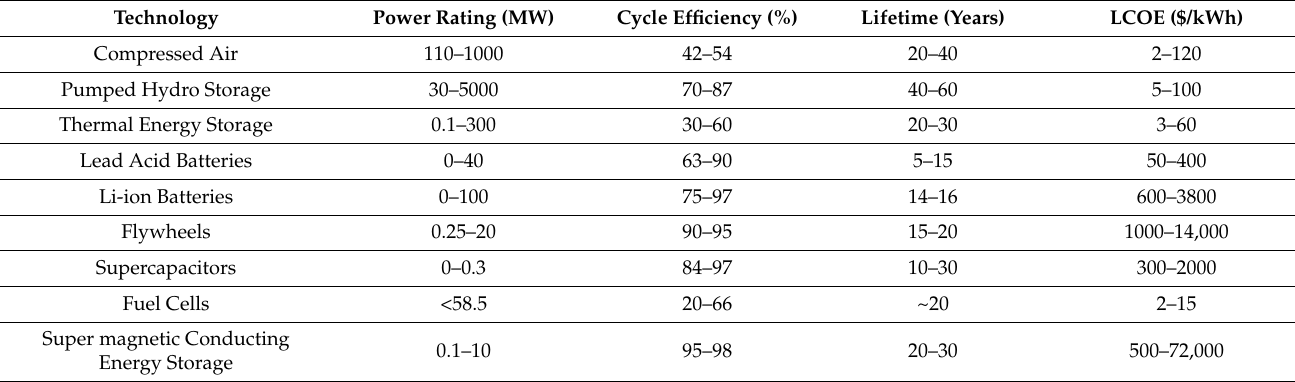
Table 6. Energy Storage Systems Comparison.